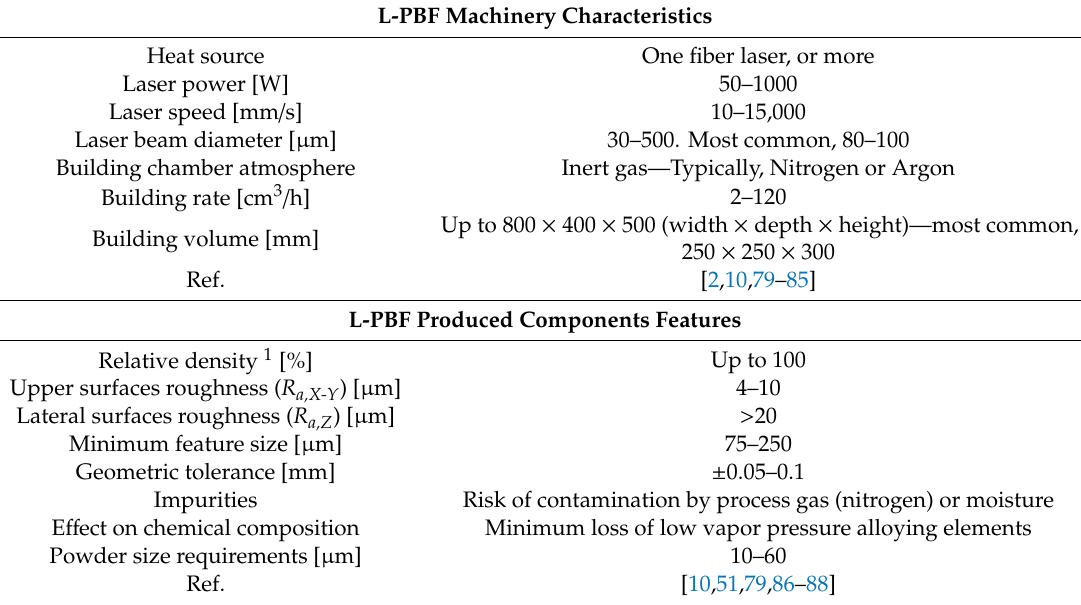
Table 1. L-PBF products and main properties.